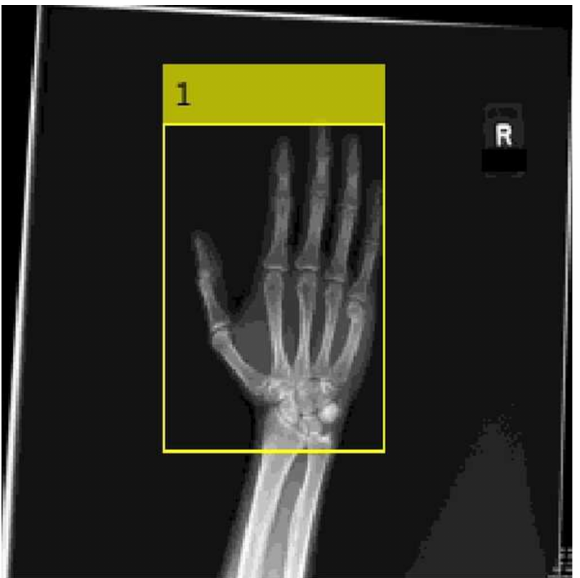
Figure 1. Example of CNN detector output image with bounding box placed over the hand. Pixelation of the image is due to the decrease in the size of the original radiograph to a smaller image size, which is suitable for CNN training and